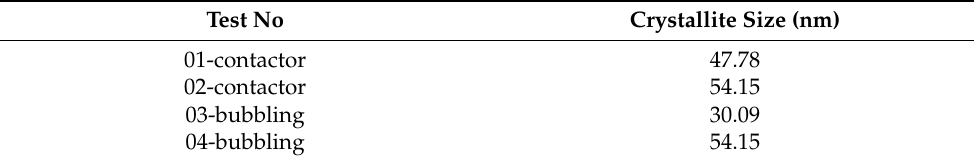
Table 3. Calcite crystallite size of all samples.